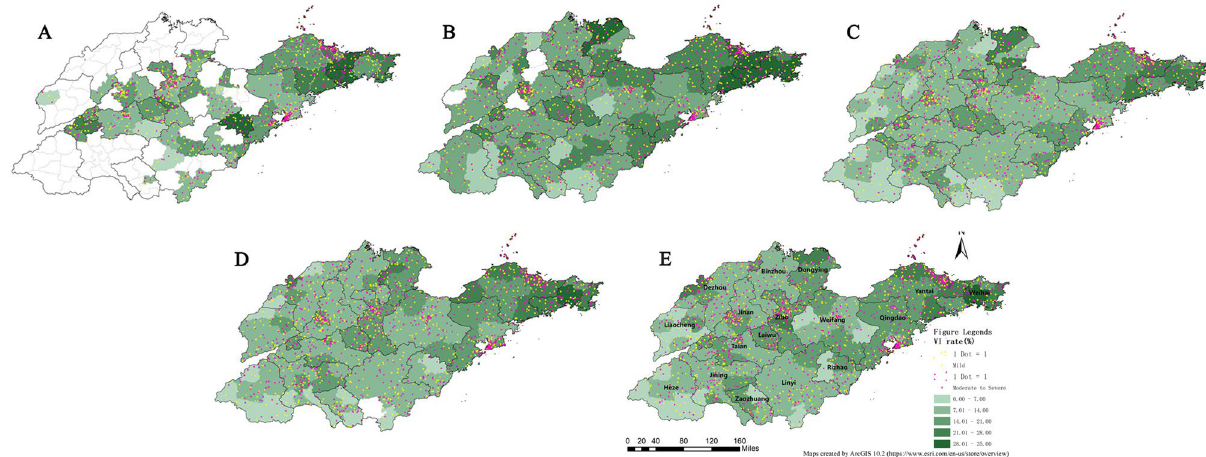
Figure 4. Spatial distribution of total visual impairment (VI) among children in Shandong province from 2013 to 2017. Figure Legends: Labels A to E represent the spatial distribution maps of each year from 2013 to 2017.